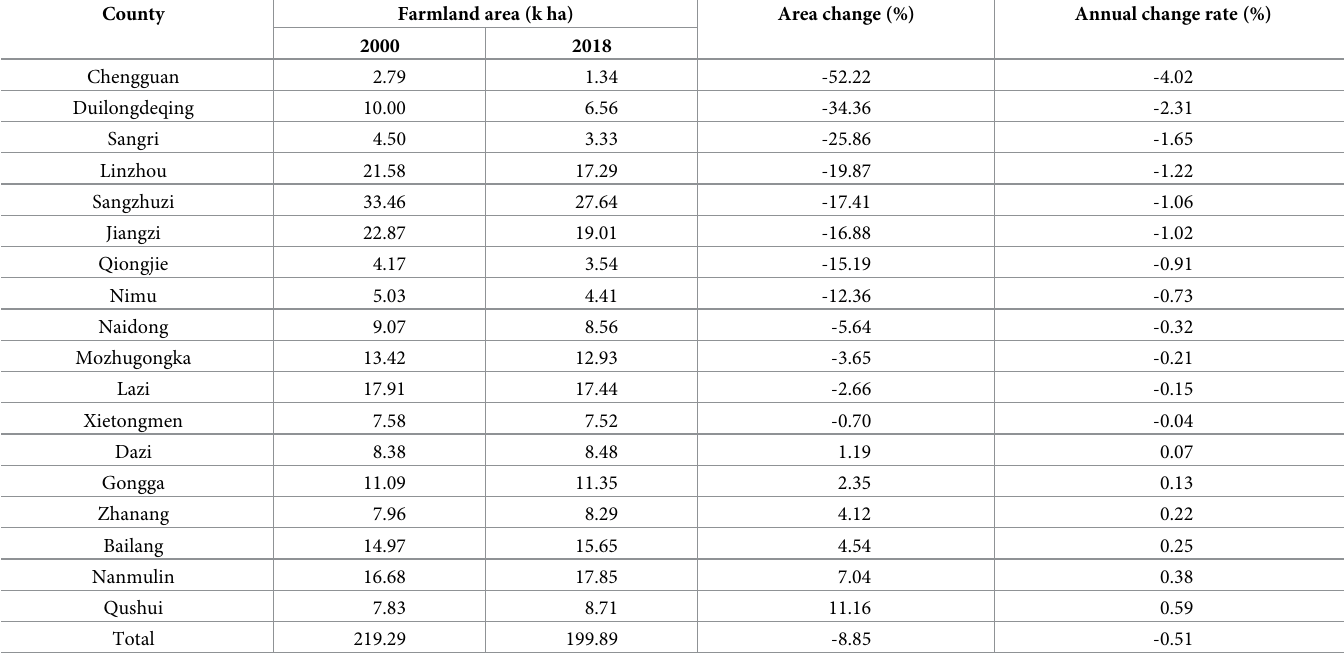
Table 1. Change of farmland area in counties of the Three River Region from 2000 to 2018. County Farmland area (k ha) Area change (%) Annual change rate (%) 2000